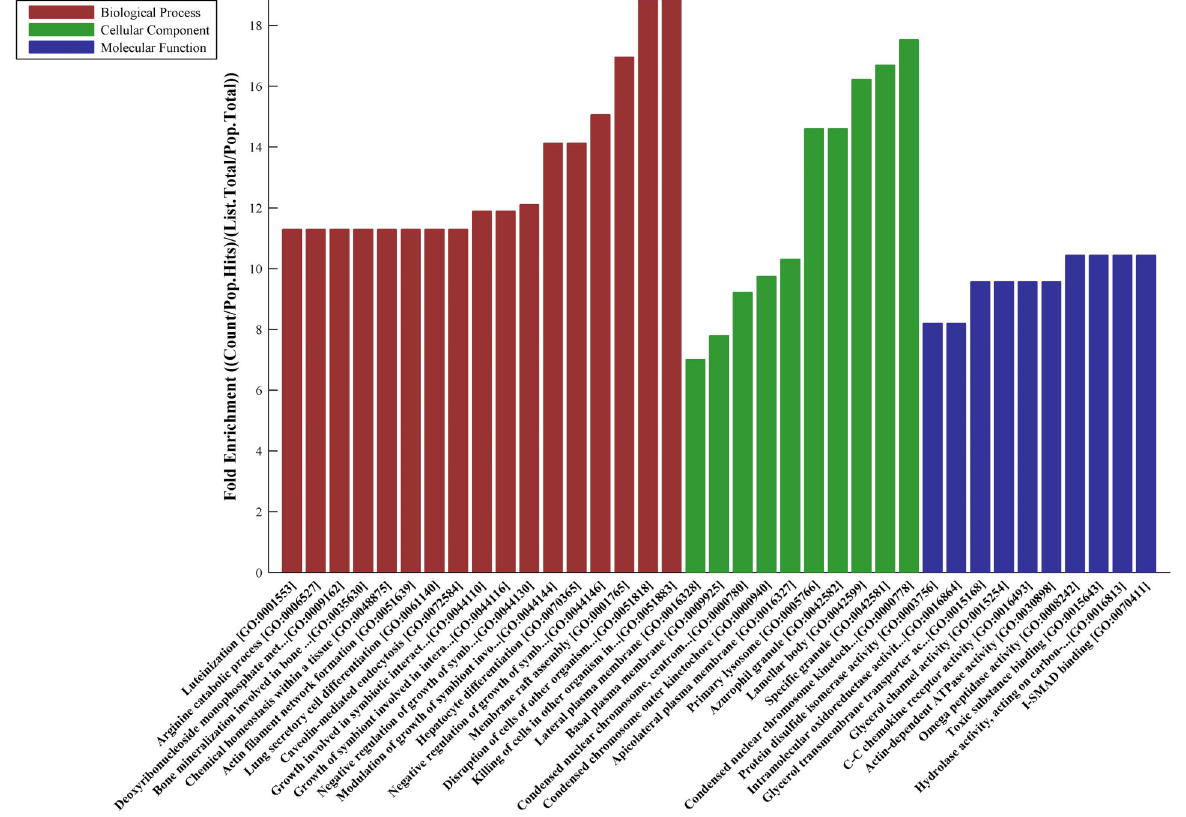
Figure 2. Analysis of the signi fi cant Gene Ontology terms (molecular function, cell component, and biological process analyses) for up-regulated